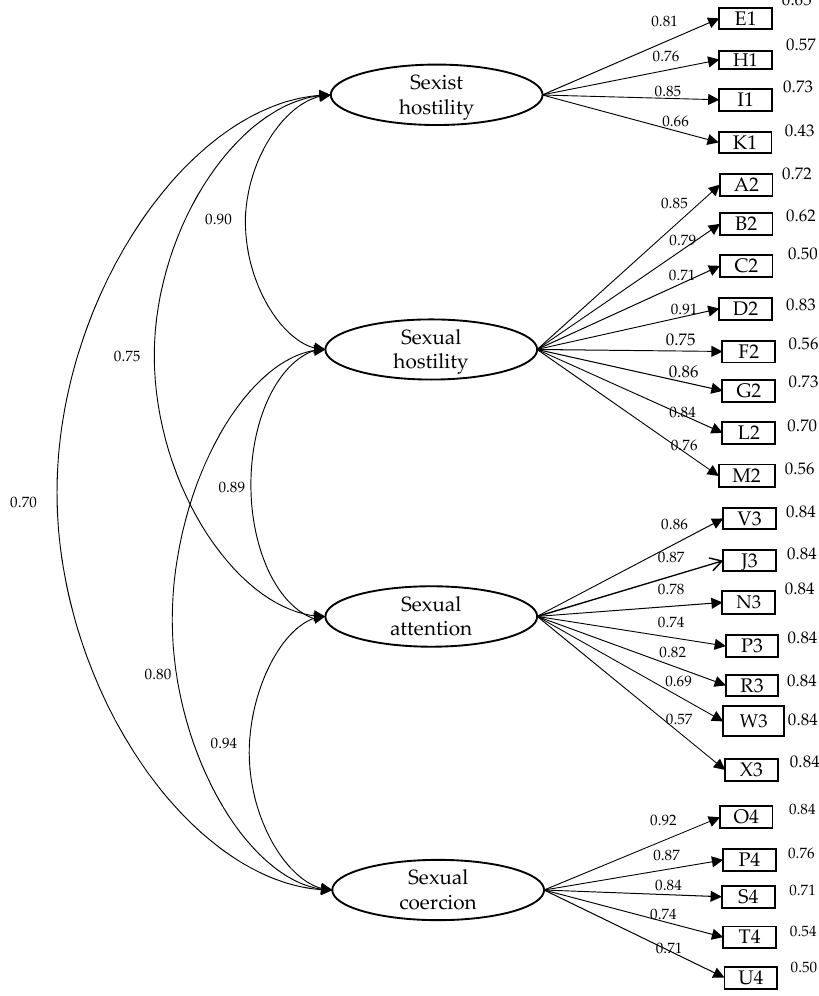
Figure 1. Structural model of ‘sexual experiences questionnaire’, Department of Defence (SEQ-DoD). Table 1. Statistics adjustment for the ‘sexual experiences questionnaire’, Department of Defence (SEQ-DoD) scale model; comparison between models using Model 1 as correct.